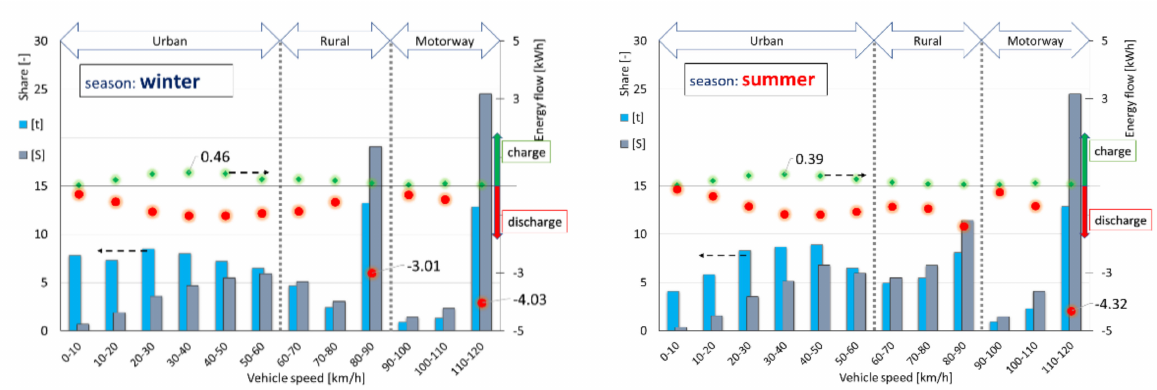
Figure 13. Energy flow characteristic and the share of energy consumption for different speed ranges in the RDC